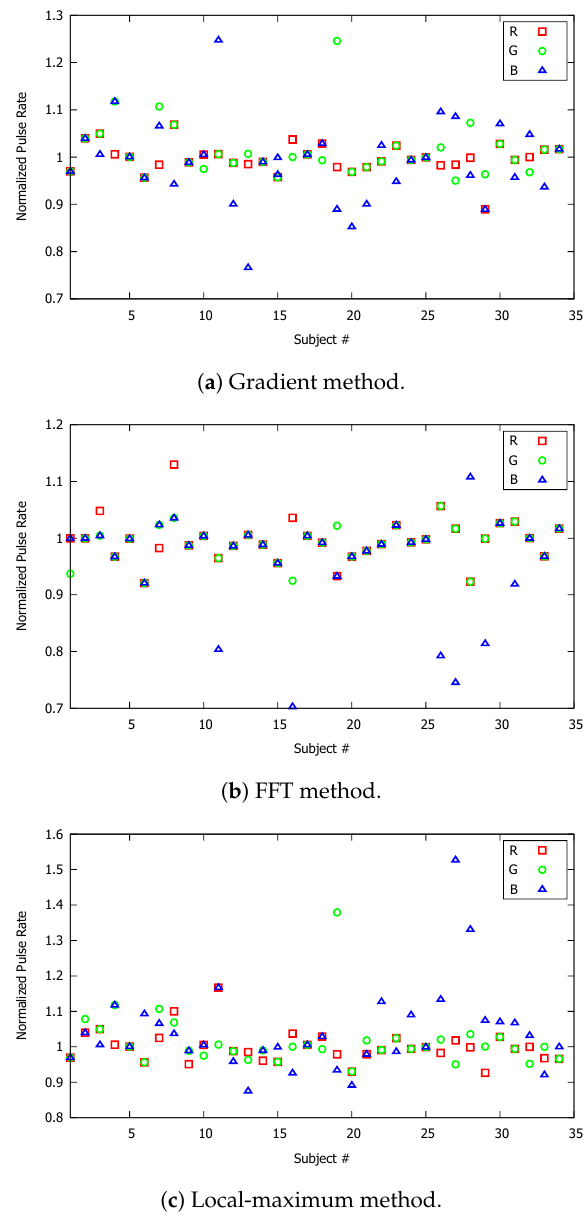
( c ) Local-maximum method. Figure 6. Normalized pulse rate (PR) of all participating volunteers; the video recording time in these graphs corresponds to 45 s. The FFT and local maximum methods were also applied to the same measurement dataset. The results of the analysis are shown in Figure 6b,c, respectively. Clearly, the red and the green channels provided better prediction of the heartbeat rate compared to the blue channel. As seen from Figure 6b, which corresponds to the FFT method, the blue markers were more dispersed from the average benchmark reading compared to the other two color markers. Specifically, the mean values for the red and the green channels were 1.00 and 0.99, respectively, whereas, for the blue channel, the mean value was 0.95, indicating a larger deviation from the benchmark reading. The same inference follows for examination of the results for the standard deviation, which was 0.107 for the blue, and 0.032 and 0.034 for the red and green channels, respectively. For the local maximum method, the results were quite similar to those for the other two methods, indicating more reliable and accurate results for the red and green channels compared to the blue